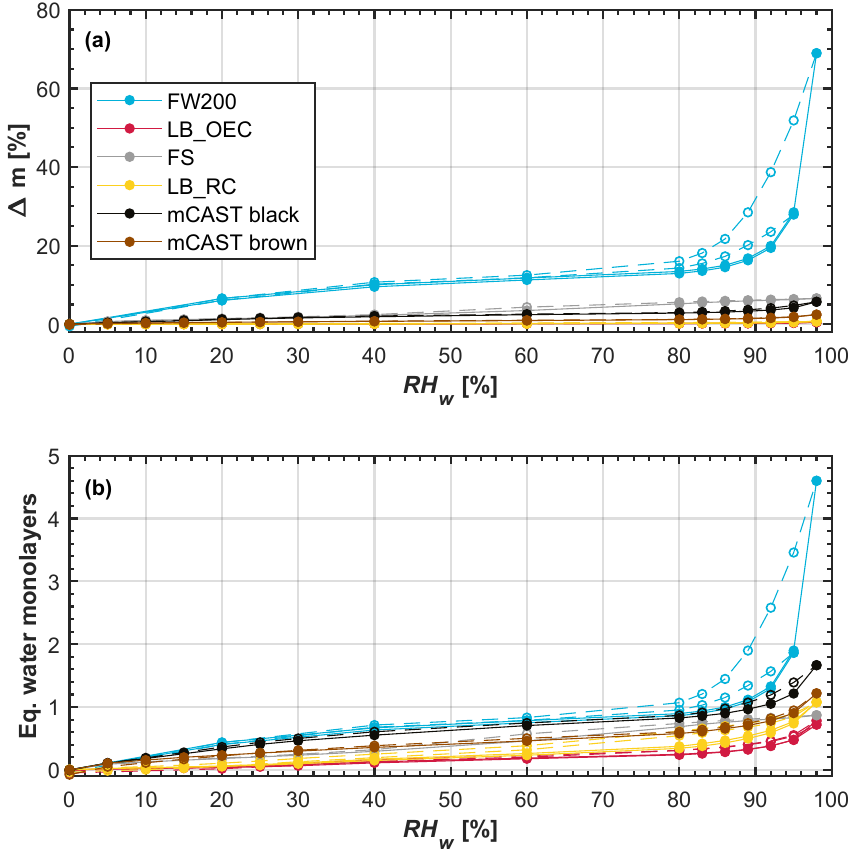
Figure 7. Water uptake (solid lines, filled symbols) and loss (dashed lines, open symbols) isotherms, given as (a) relative sample mass change and (b) equivalent water monolayers, as a function of RH w , as measured by DVS at T = 298K. Each set of curves corresponds to an individual, independent soot sample. The data points represent water uptake and loss at quasi-equilibrated RH w conditions. Each soot type was probed for two independent experiments in the DVS and the curves of the two independent runs lie on top of each other. Exceptions are the mCAST samples, which were only probed once in the DVS. Curves are linear interpolations between quasi-equilibrated sample points to guide the eye. The curves of the LB_OEC and LB_RC samples lie on top of each other in panel (a) . All experiments were performed to a maximum RH w of 98%, with the exception of one FW200 sample showing a maximum relative mass change of approximately 30%, which was only probed up to RH w =